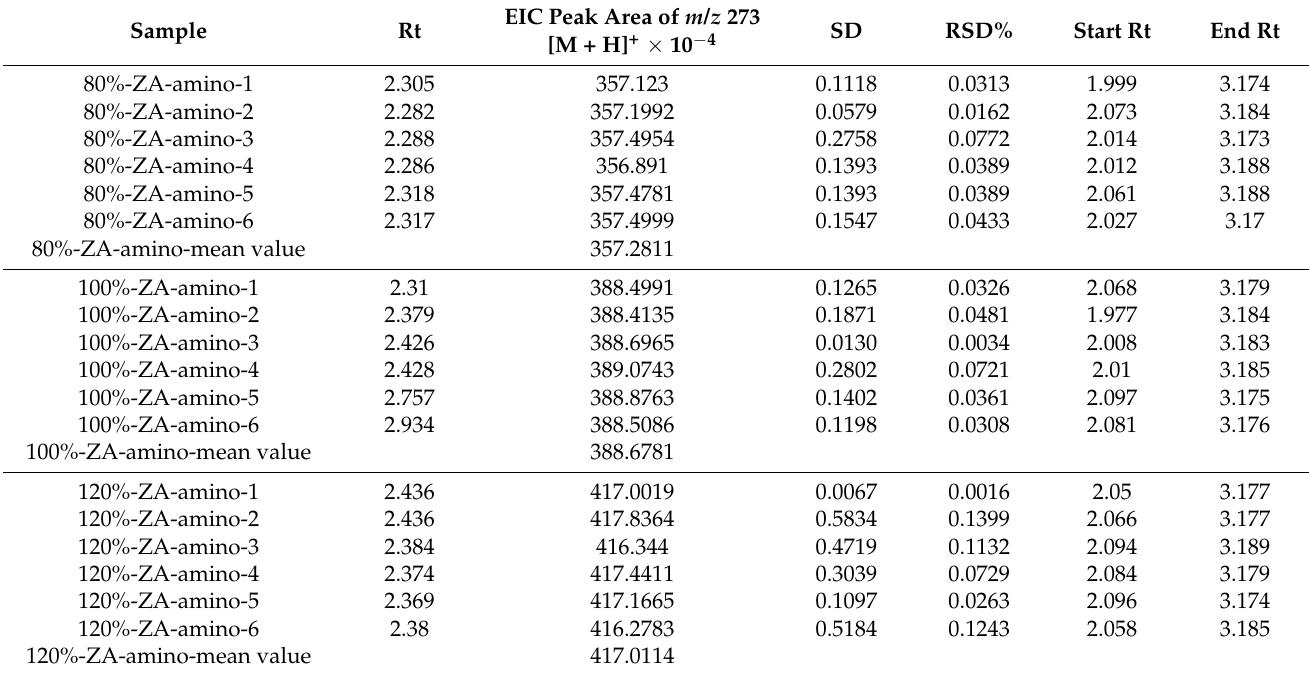
Table 2. Data recorded and calculated for accuracy